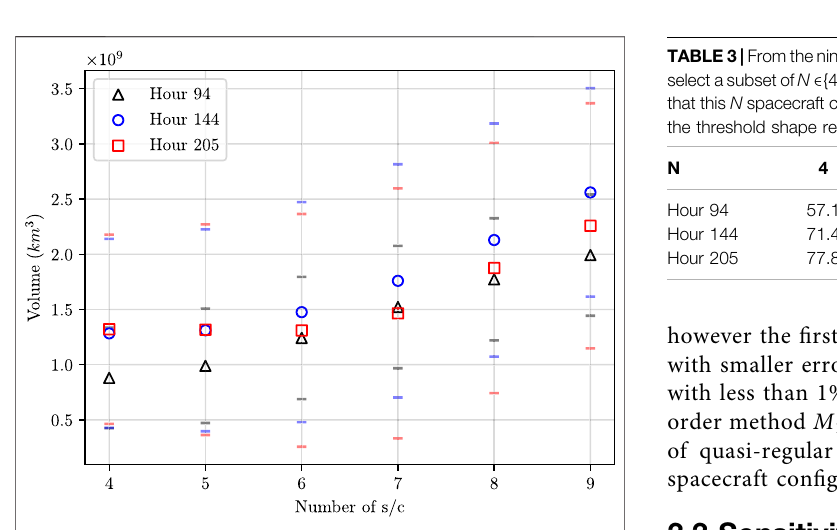
right panel of each fi gure because the spacecraft are equidistant from the z (cid:1) 0 plane.